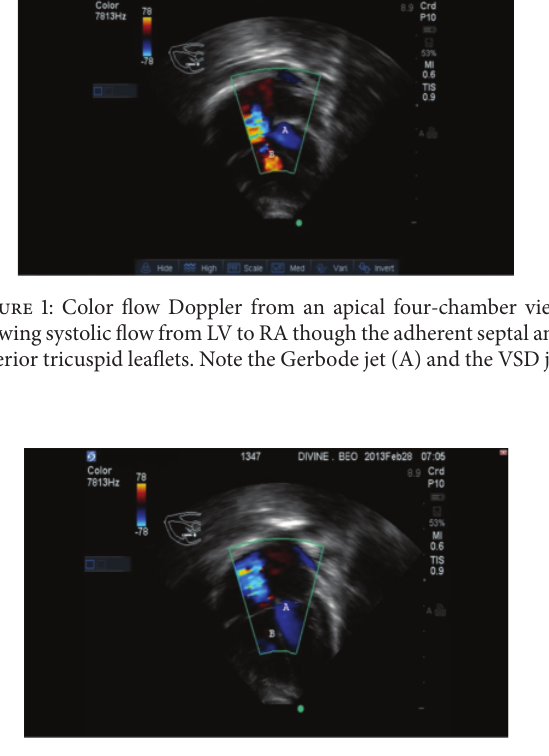
Chest X-ray showed situs solitus, levocardia, mild car- diomegaly; and pulmonary plethora. ECG showed normal sinus rhythm, extreme right axis deviation; and left ventricu- lar